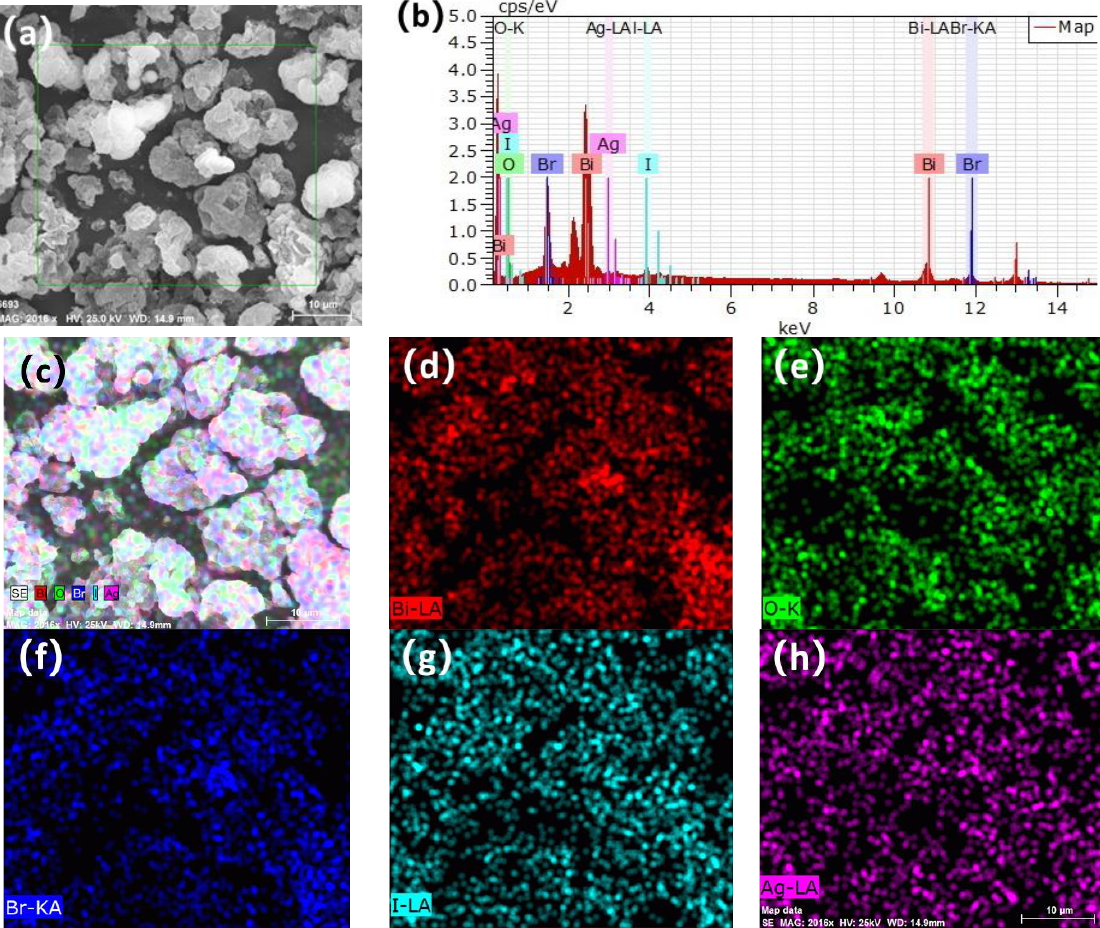
Figure 3. TEM images of BiOBr 0.85 I 0.15 , ( a , b ); 1.0% Ag/BiOBr 0.85 I 0.15 , ( c , d ).